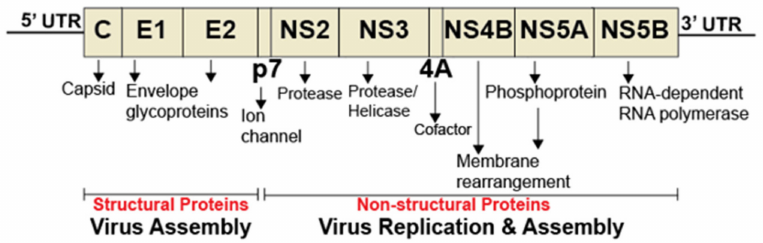
Figure 2. Diagram of hepatitis C virus genome. The HCV genome consists of a single open reading frame (ORF) flanked by the 5’ and 3’ untranslated regions (UTRs). The ORF is translated into a single polyprotein, which is further processed into individual proteins. The 5’ and 3’ UTRs are critical for internal ribosome binding, translation, and HCV genome